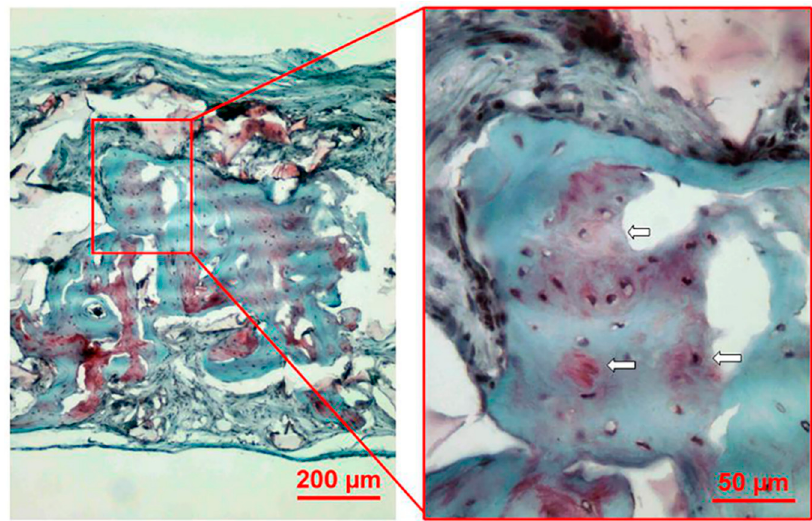
Figure 2. Safranin O-fast green staining results. Specimens of the CO group at week 8 after implantation were stained with a safranin O-fast green procedure. Newly formed osteoid was illustrated by the gray green color and nuclei by the gray black color. Red areas (depicted by white arrows) represented cartilage-like tissue.